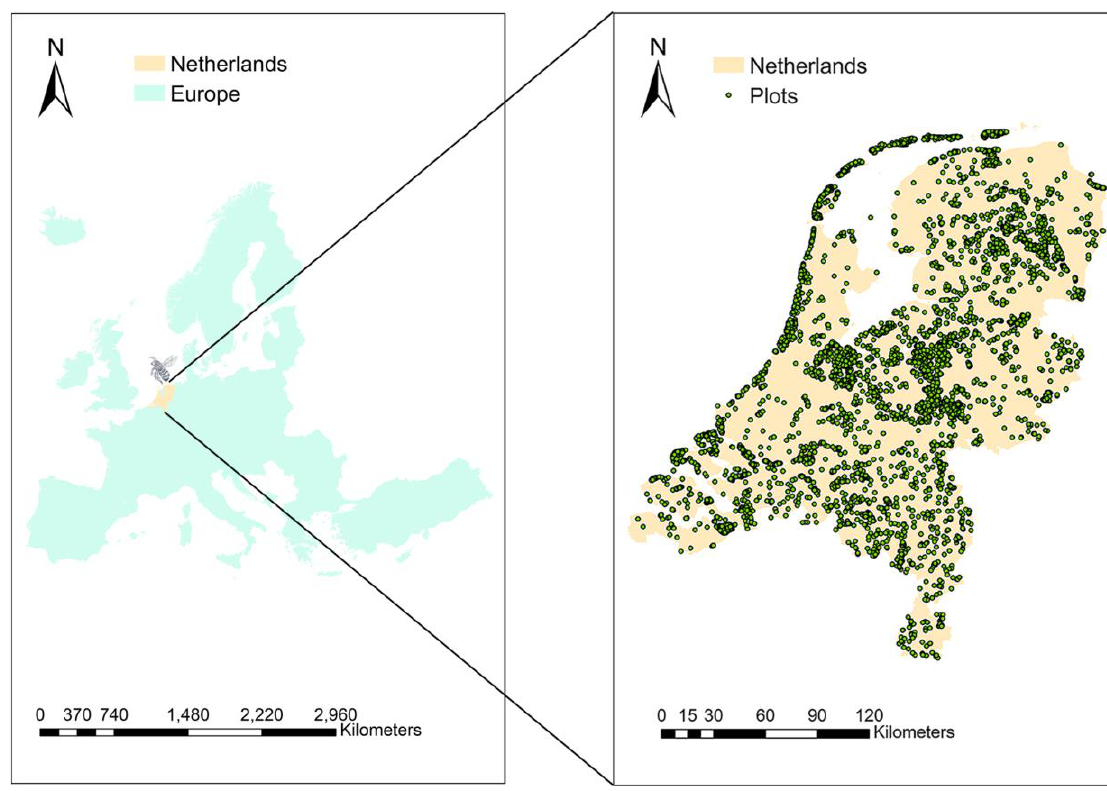
Figure 1. The distribution of 11,937 plots with coordinates and sample sizes between 1-1000 m 2 and matched with the habitat types map. Map projection: EPSG:28992, Amersfoort / RD